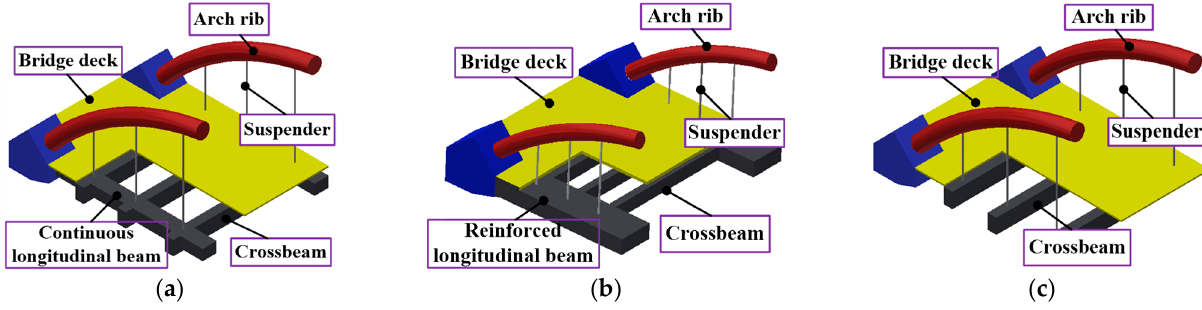
Figure 1. Three types of the bridge deck system structure: ( a ) first type; ( b ) second type; ( c ) third